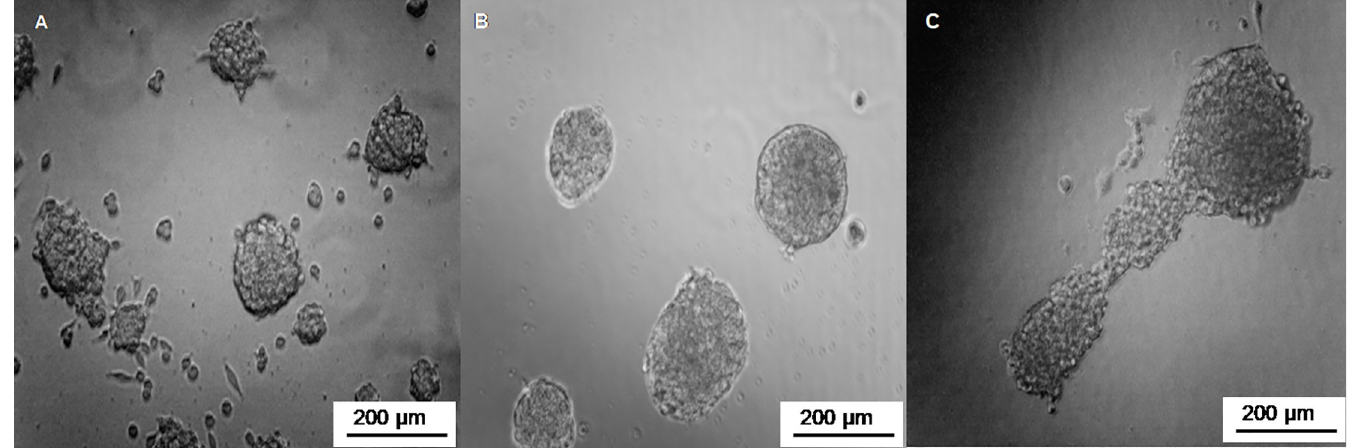
Fig 2. Micrographs of (A) HeLa, (B) PANC-1; and (C) Caco-2 cells imaged 72 h after seeding on PEG60000 (C.E.) pre-treated surfaces.